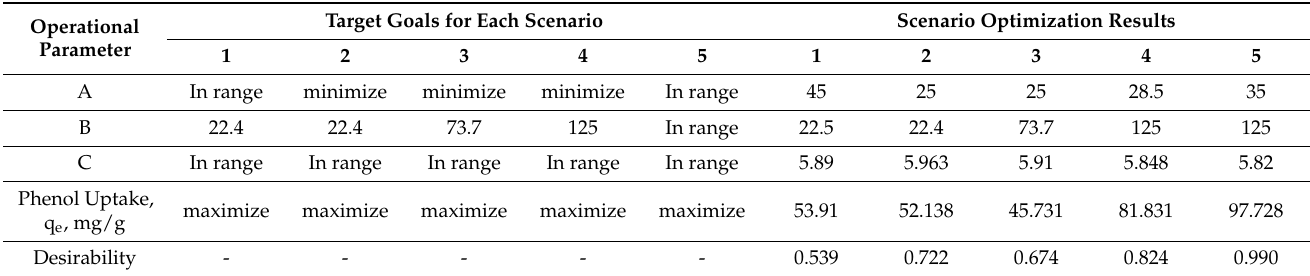
Table 3. RSM predicted numerical optimization scenarios result for SBAC-MgAlFe-LDH phenol uptake. Operational